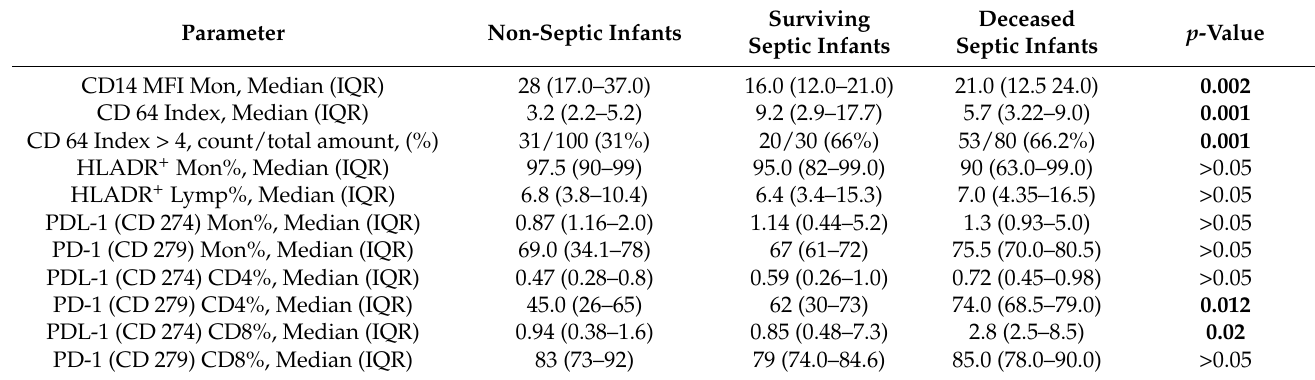
Table 5. Functional markers of blood cells in newborns hospitalized with